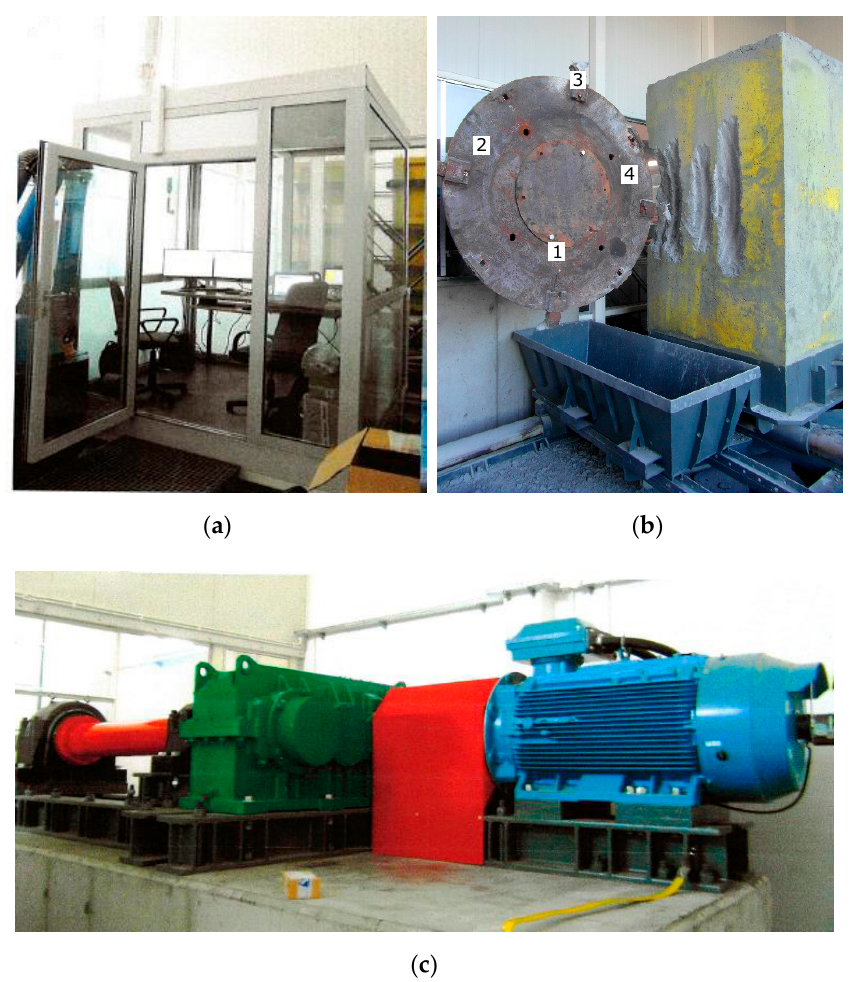
Figure 9. Laboratory test stand for testing by cutting or rotary drilling with single cutting tools or heads: ( a ) operator’s cab; ( b ) concrete sample as well as a test cutting head; ( c ) head drive [29,37].